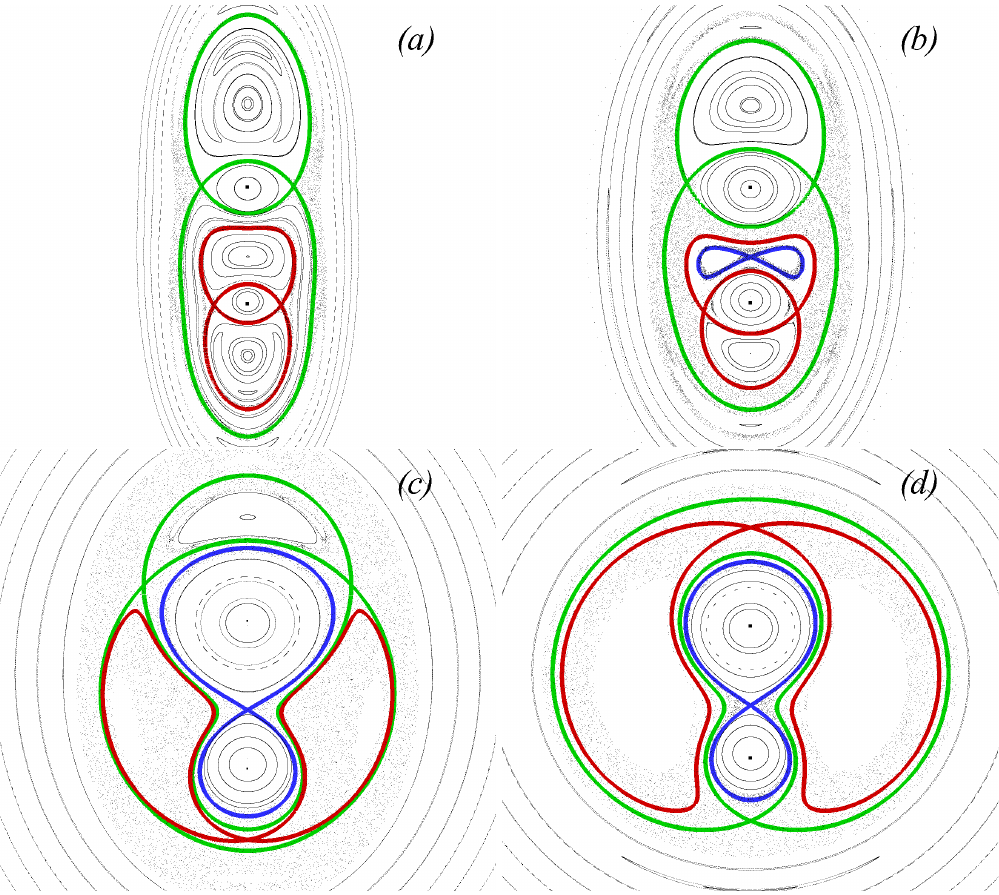
Figure 19. Poincaré maps of the perturbed advection system as the vortices are shifted by 0.3 from their stationary positions. Colour-coded are the steady-state separatrices, which vanish as the perturbation is toggled. The corresponding steady-state configurations shown in Figure 17 for S 0 : ( a ) − 0.014; ( b ) − 0.01; ( c ) − 0.005; and ( d ) −